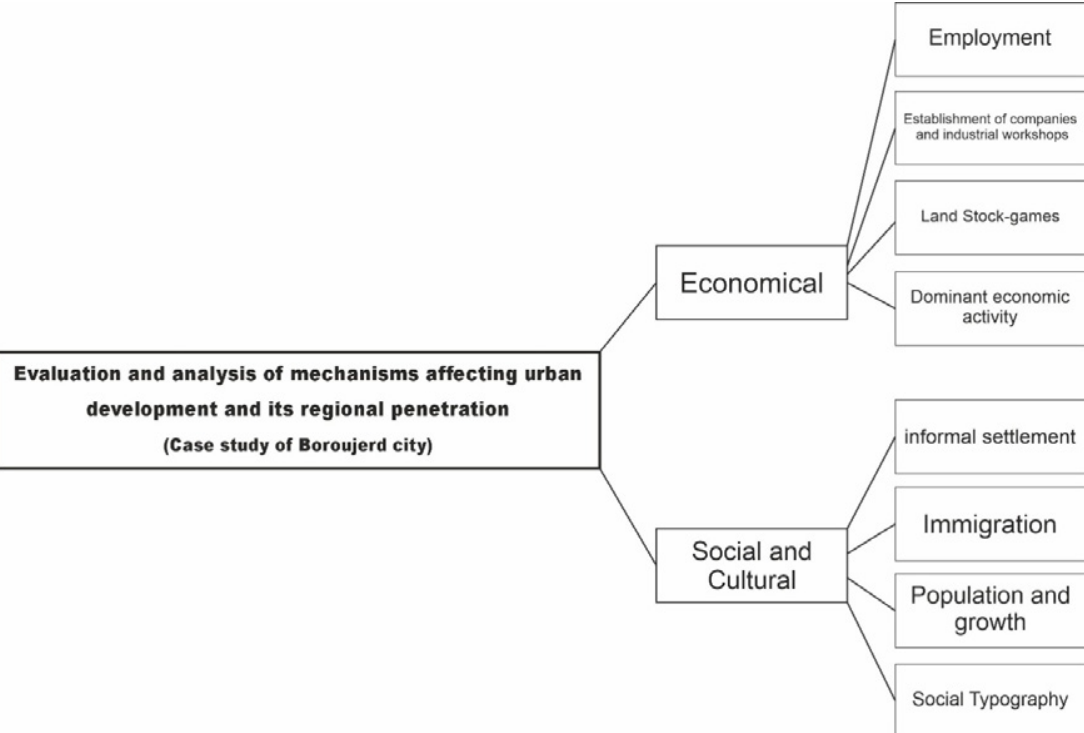
Fig. 1: Research conceptual framework